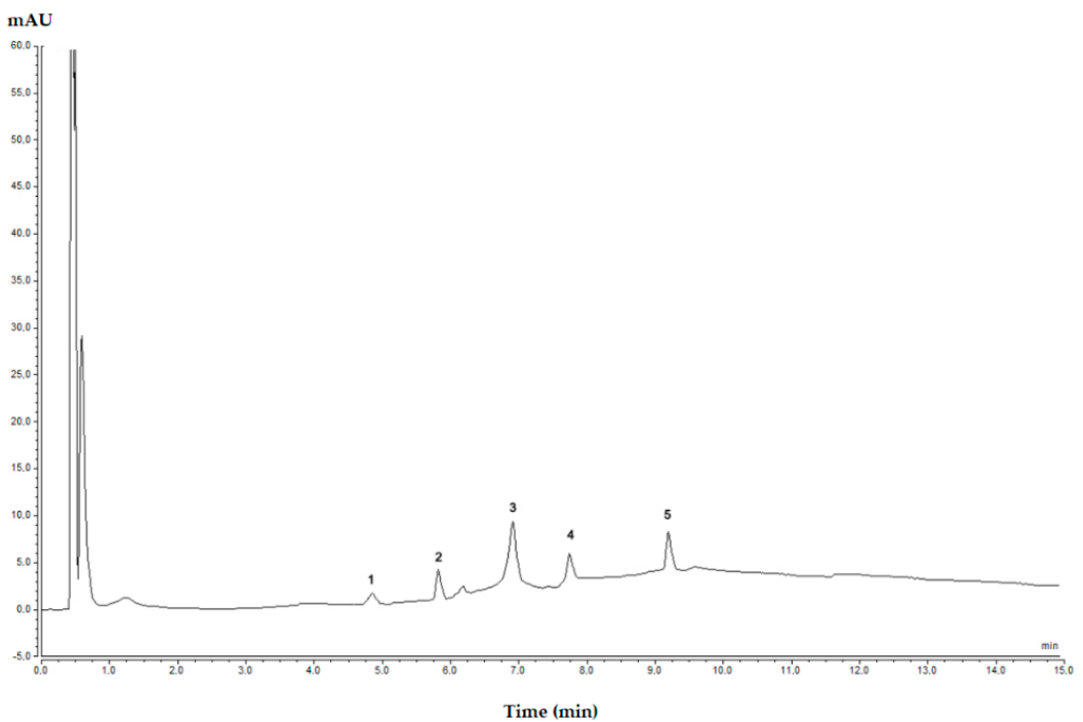
Figure 5. A representative chromatogram obtained from Lake water spiked at 50.0 µ g · L − 1 , after FPSE procedure coupled with High-Performance Liquid-Chromatography–Photodiode Array Detection (FPSE-HPLC–DAD) (1. MIRT, 2. BUP, 3. CLO, 4. CIT, 5. SERT). Table 4. Analytical parameters of hospital and urban effluents and surface water samples (n = 3).